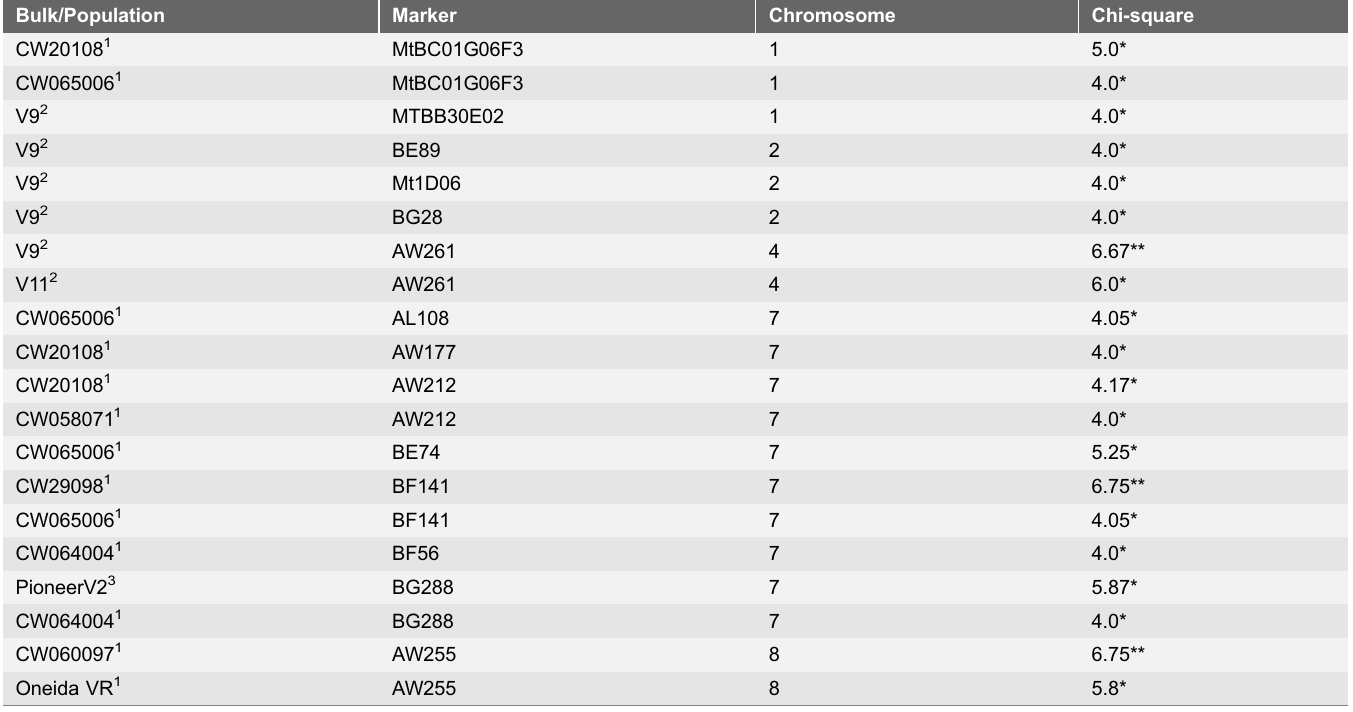
Table 1. Significant SSR markers identified via bulk segregant analysis in alfalfa